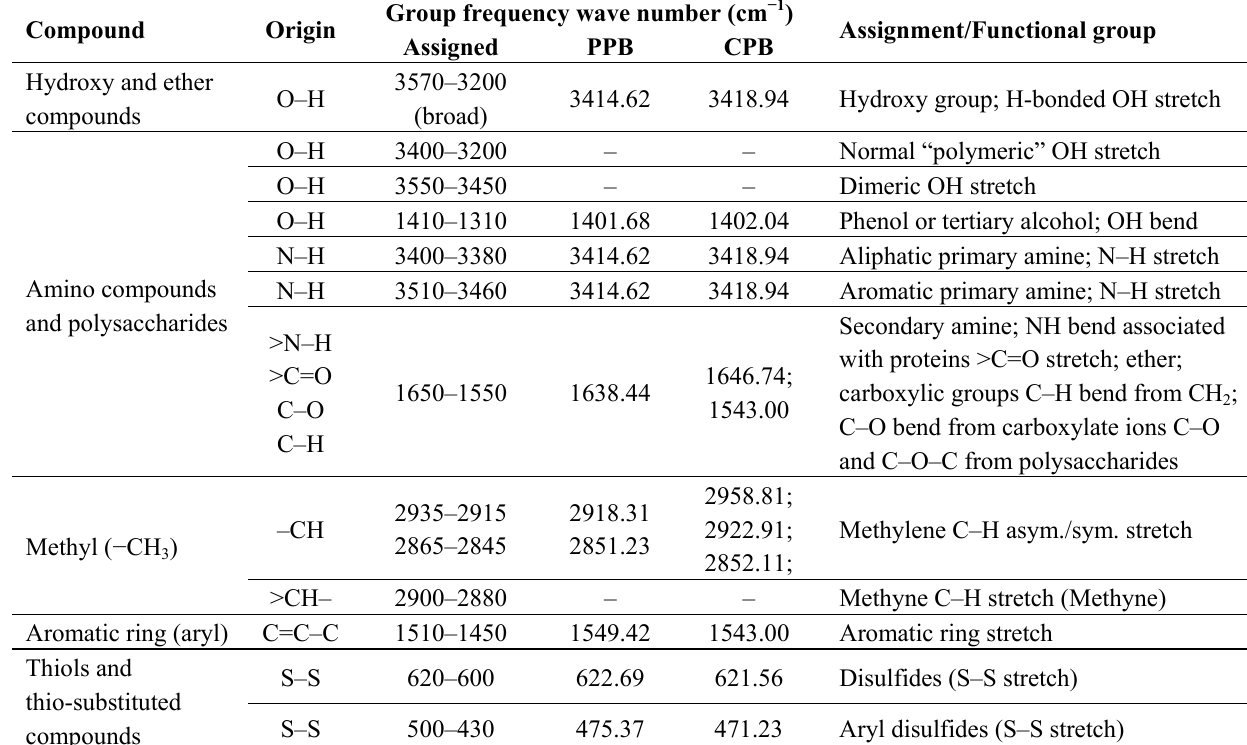
Table 2. Position and characteristic bond obtained from Fourier transform infrared spectroscopy of bioflocculants from Brachybacterium sp.